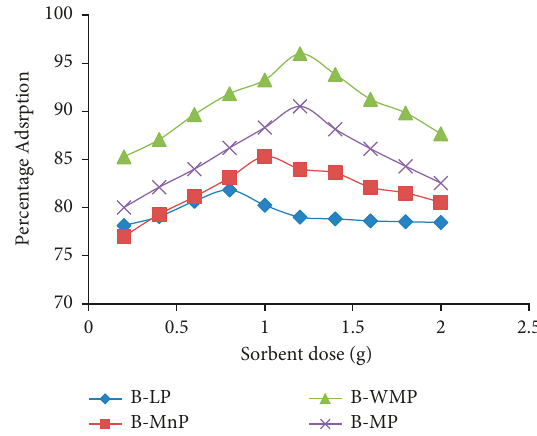
Figure 4: Effect of sorbent dose on the sorption of Cr (VI).